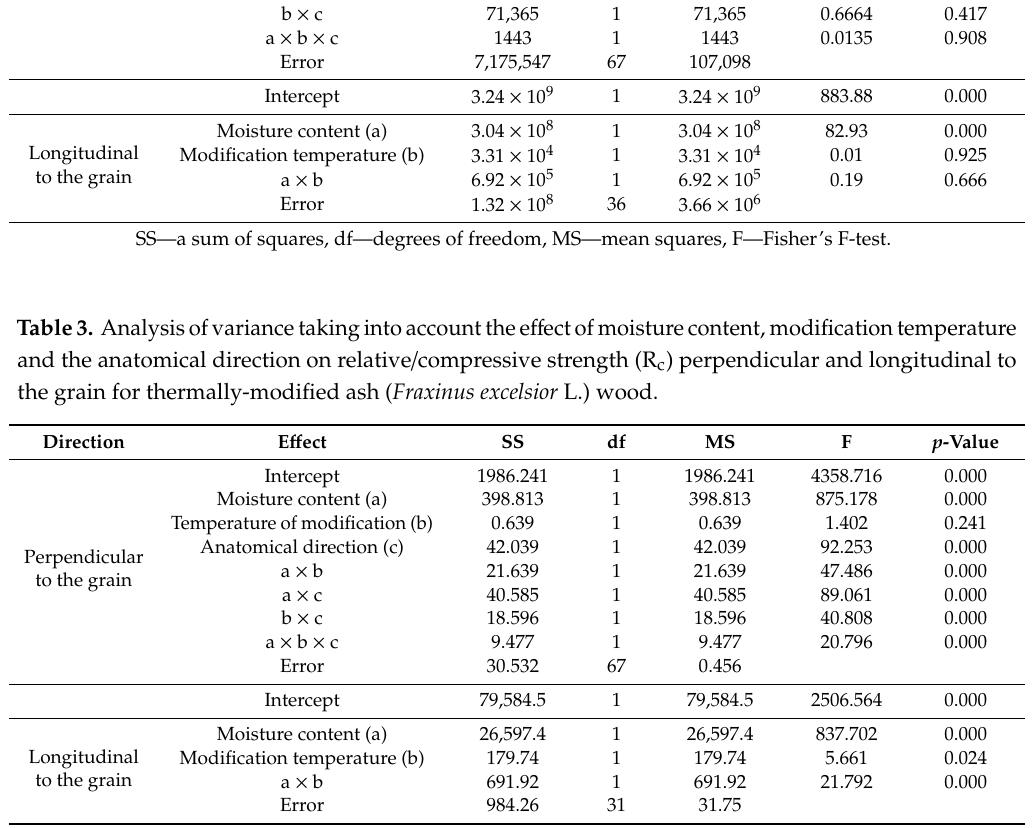
Perpendicular to the grain